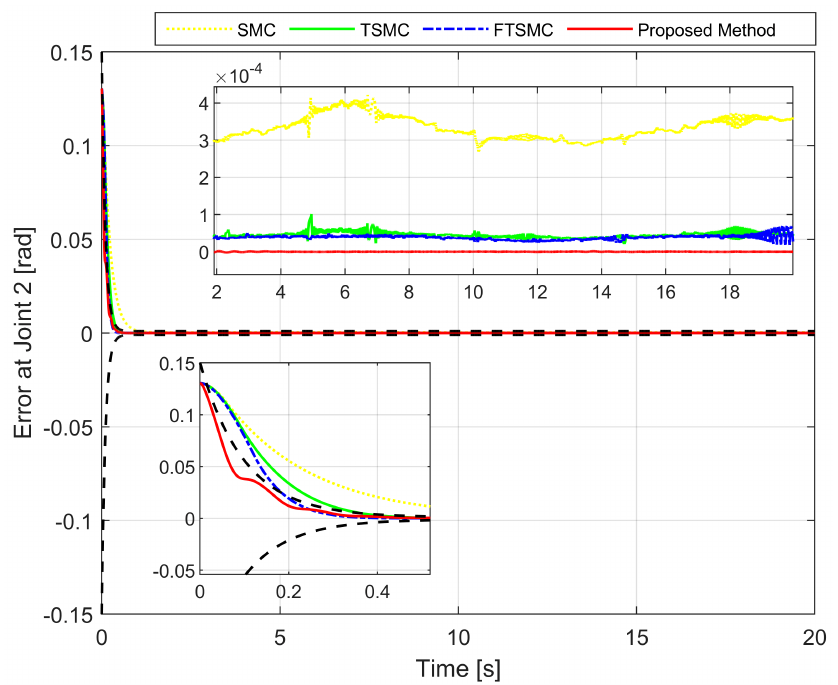
Figure 4. The second joint error comparison between the real trajectory of the robot and the refer- ence